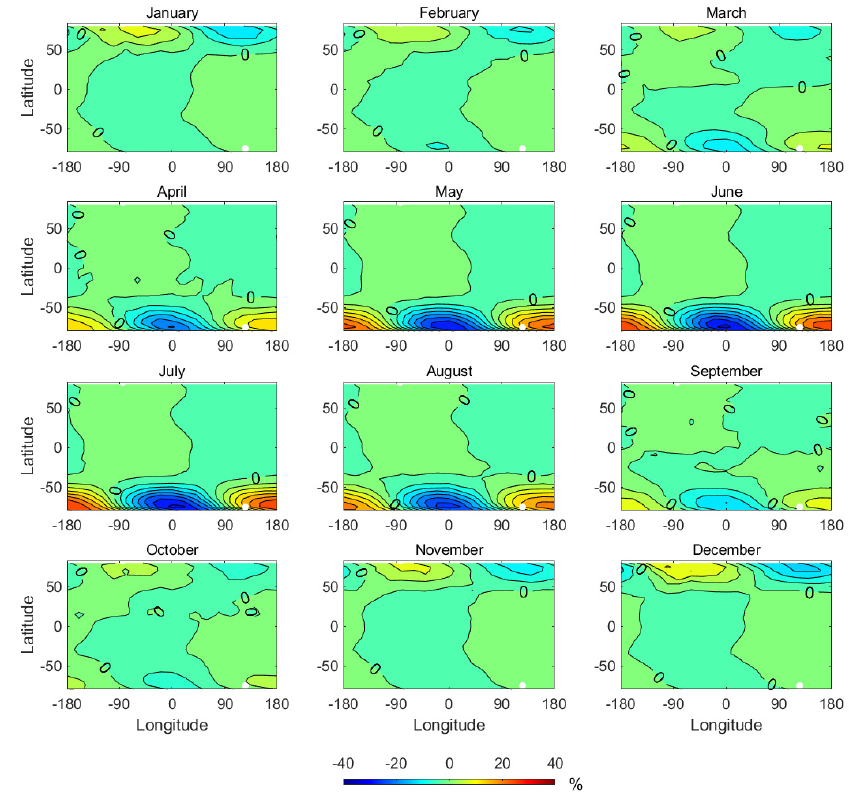
Figure 8. Same as Figure 6, except for the atmospheric average molecular weight.